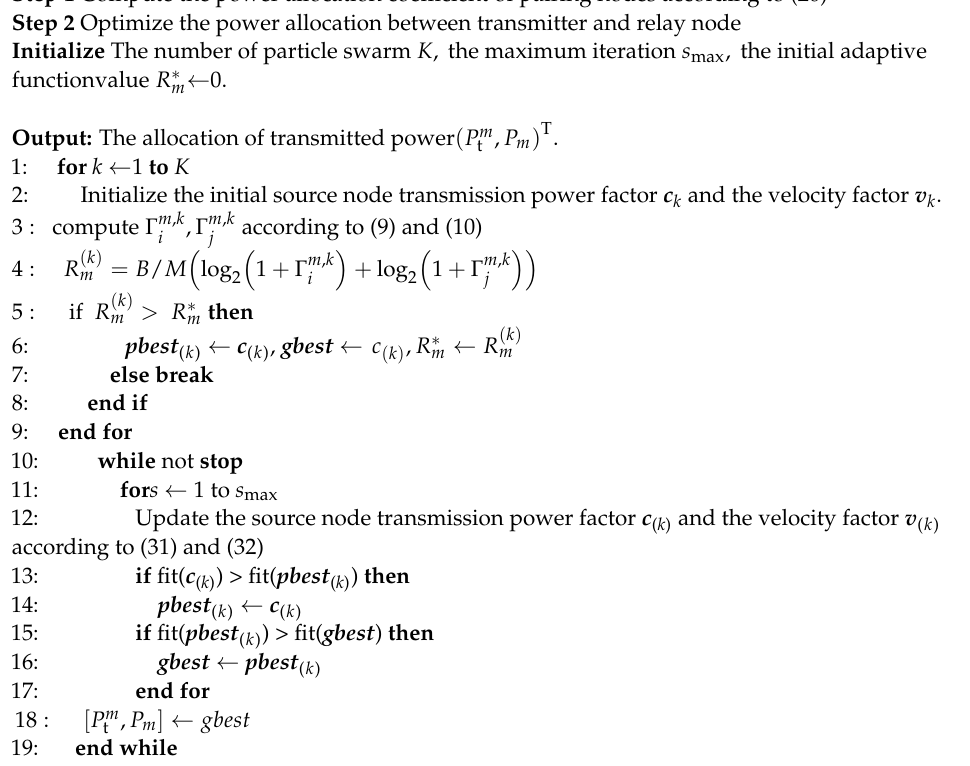
Algorithm 3 Stepwise Sub-Optimization Power Allocation Step 1 Compute the power allocation coefficient of pairing nodes according to (26) Step 2 Optimize the power allocation between transmitter and relay